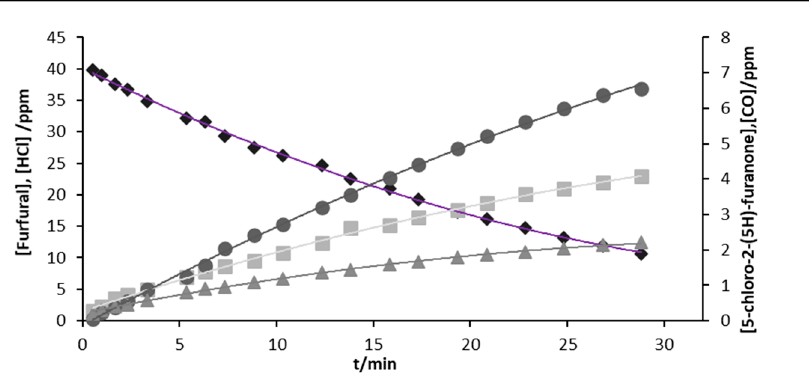
Figure 3. FTIR concentration–time profiles for the reaction of furfural with chlorine atoms. ♦ Furfural, ■ HCl, ● CO, ▲ 5-chloro-2-(5 H )-furanone.